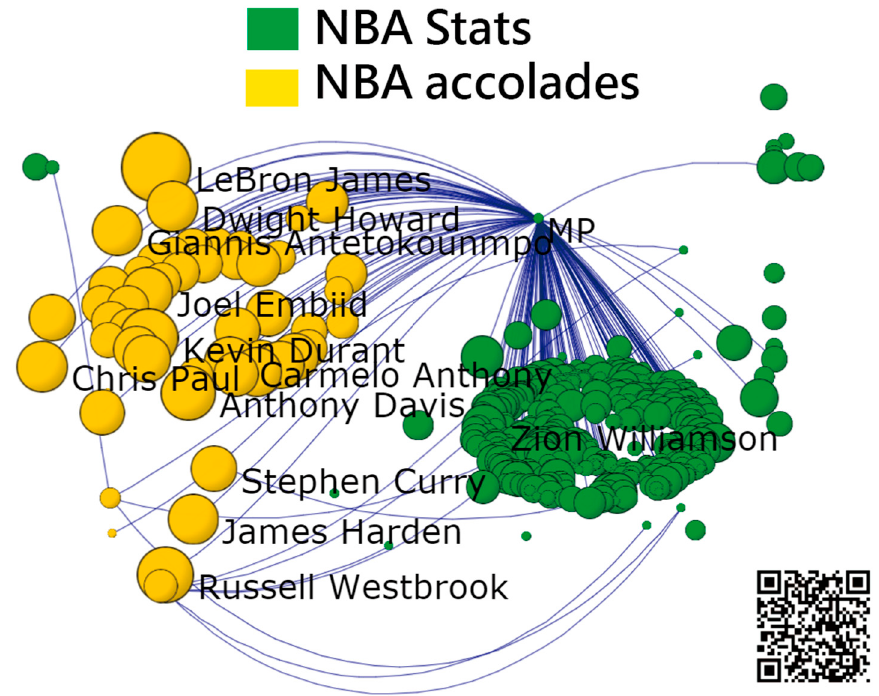
Figure 7. Classification of active NBA players using social network analysis.